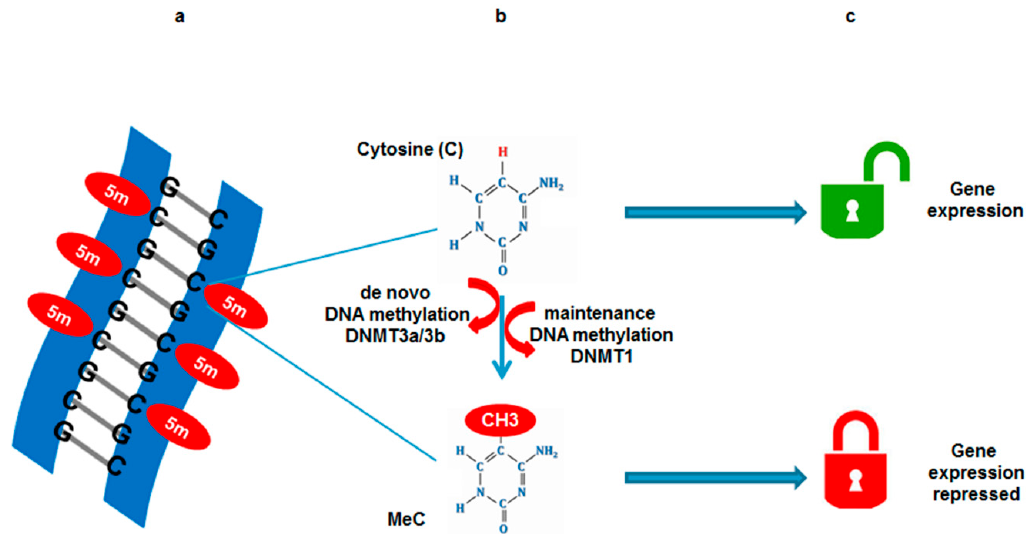
Figure 2. DNA methylation and gene expression. ( a ) DNA methylation occurs at cytosine bases (CpG islands) when a methyl group is added at the 5 ′ position on the pyrimidine ring by DNA methyl transferases (DNMTs); ( b ) Two types of DNMTs initiate de novo DNA methylation; DNMT3a and DNMT3b to methylate previously unmethylated cytosines (C), whereas maintenance DNMTs (DNMT1) methylate hemi-methylated DNA at the complementary strand; ( c ) Methyl group tags DNA and represses gene expression.